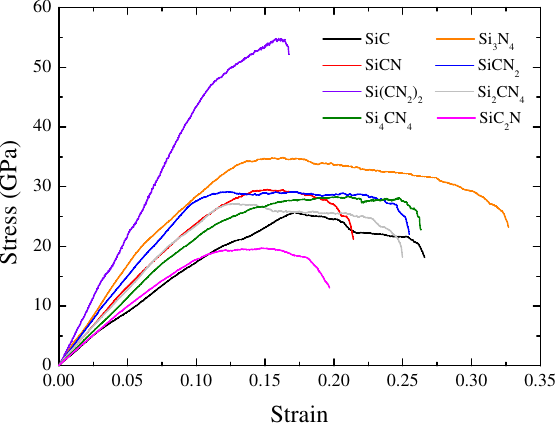
Figure 6. Stress–strain curves of the amorphous SiC, Si 3 N 4 , and SiC x N y .